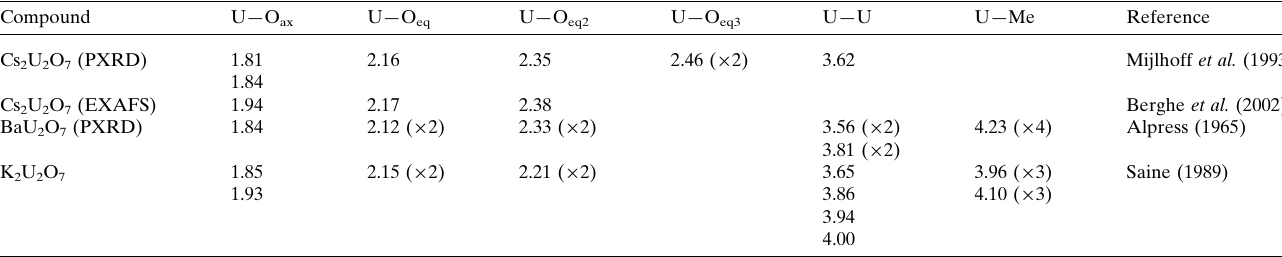
Table 2 Distances to the nearest coordination spheres in Cs, Ba and K diuranates.